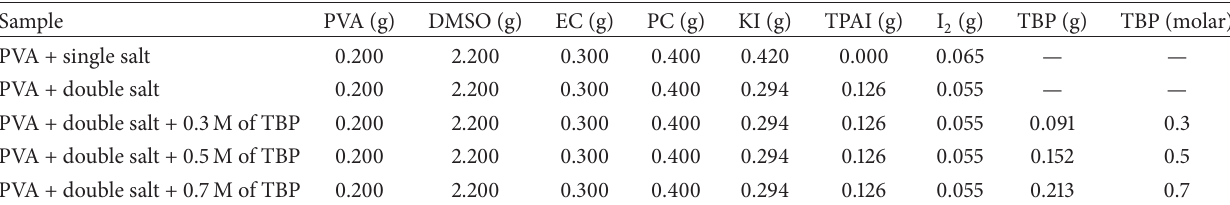
Table 1: Composition of the